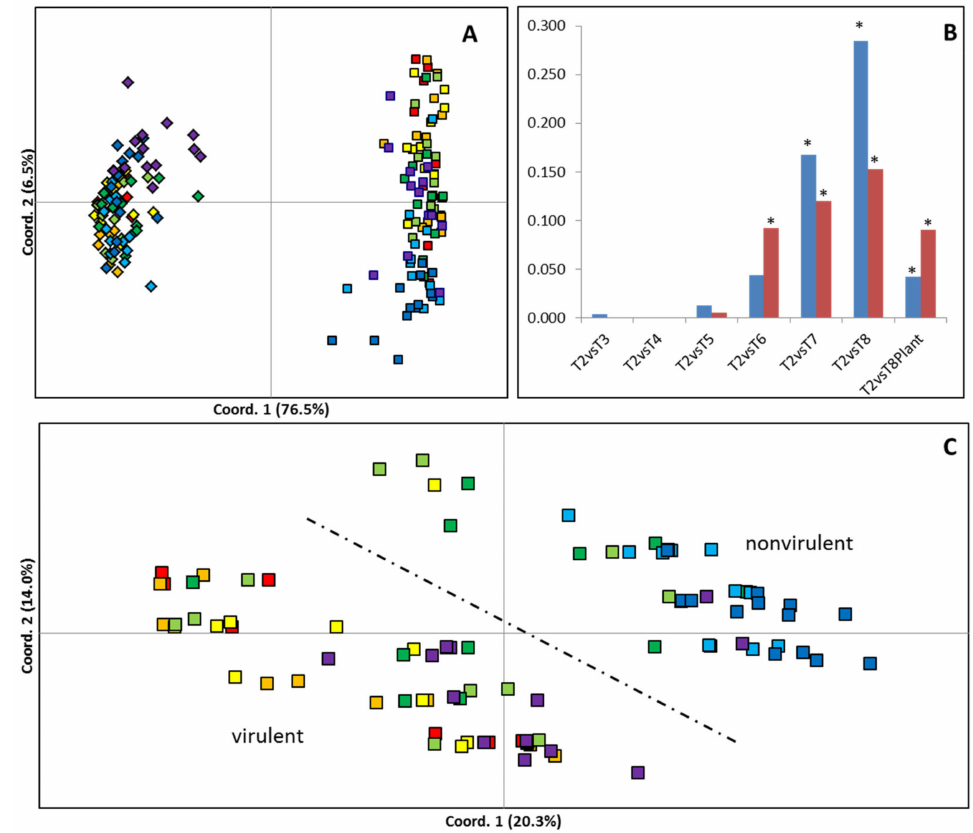
Figure 2. Effect of time in culture on genetic/epigenetic instability. ( A ,C) Principal coordinate diagrams based on the Euclidian analysis of methylation-sensitive amplified polymorphisms (MSAPs) using ( A ) enzymes Hpa II (squares) and Msp I (rhomboids) and using ( C ) enzyme Hpa II distances; 14 replicates from each time point are represented as red (T2: 2 months in culture), orange (T3: 3 months in culture), yellow (T4: 4 months in culture), light green (T5: 5 months in culture), dark green (T6: 6 months in culture), light blue (T7: 7 months in culture), dark blue (T8: 8 months in culture), and purple (T8P: 8 months + plant). The dashed line separates samples with higher average levels of virulence from those with lower average levels of virulence. ( B ) Calculated pairwise PhiPT (Michalakis and Excoffier, 1996) comparisons between samples restricted with Hpa II (Blue) or Msp I (Red) from each time point and the samples after the second passage (2 months in culture). * Indicates significantly different PhiPT values between T2 and the time point under the asterisk based on 10,000 permutations ( p =